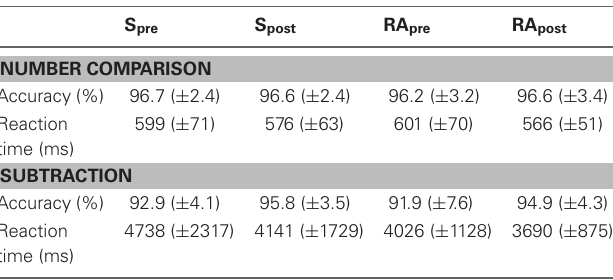
Table 2 | Effects of tDCS on accuracy and reaction times in Experiment